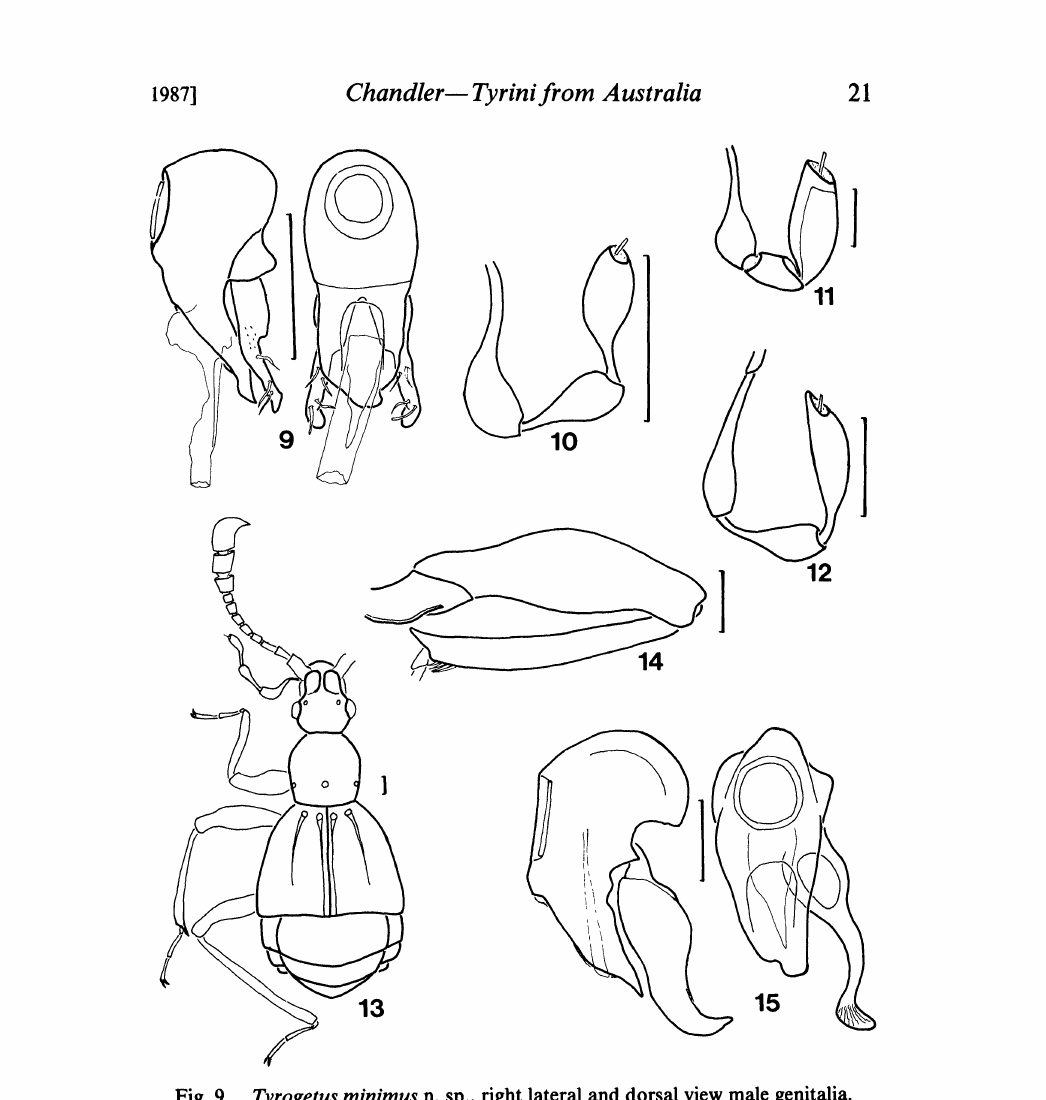
Fig. 9. Tyrogetus minimus n. sp., right lateral and dorsal view male genitalia. Fig. 10. Tasmanityrus auricomus (Lea), dorsal view right maxillary palpus. Fig. 11. Tyromorphus comes (Schaufuss), dorsal view right maxillary palpus. Fig. 12. Gerallus palpalis (King), dorsal view right maxillary palpus. Fig. 13-15. Tasmanityrus hilli n. sp. 13. Dorsal habitus; 14. posterior view right middle leg; 15. right lateral and dorsal view male